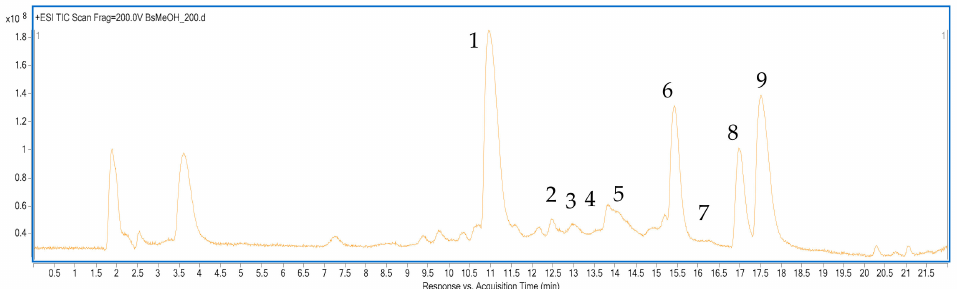
Figure 1. The total ion chromatogram of the methanolic extract from Berberis cretica roots.